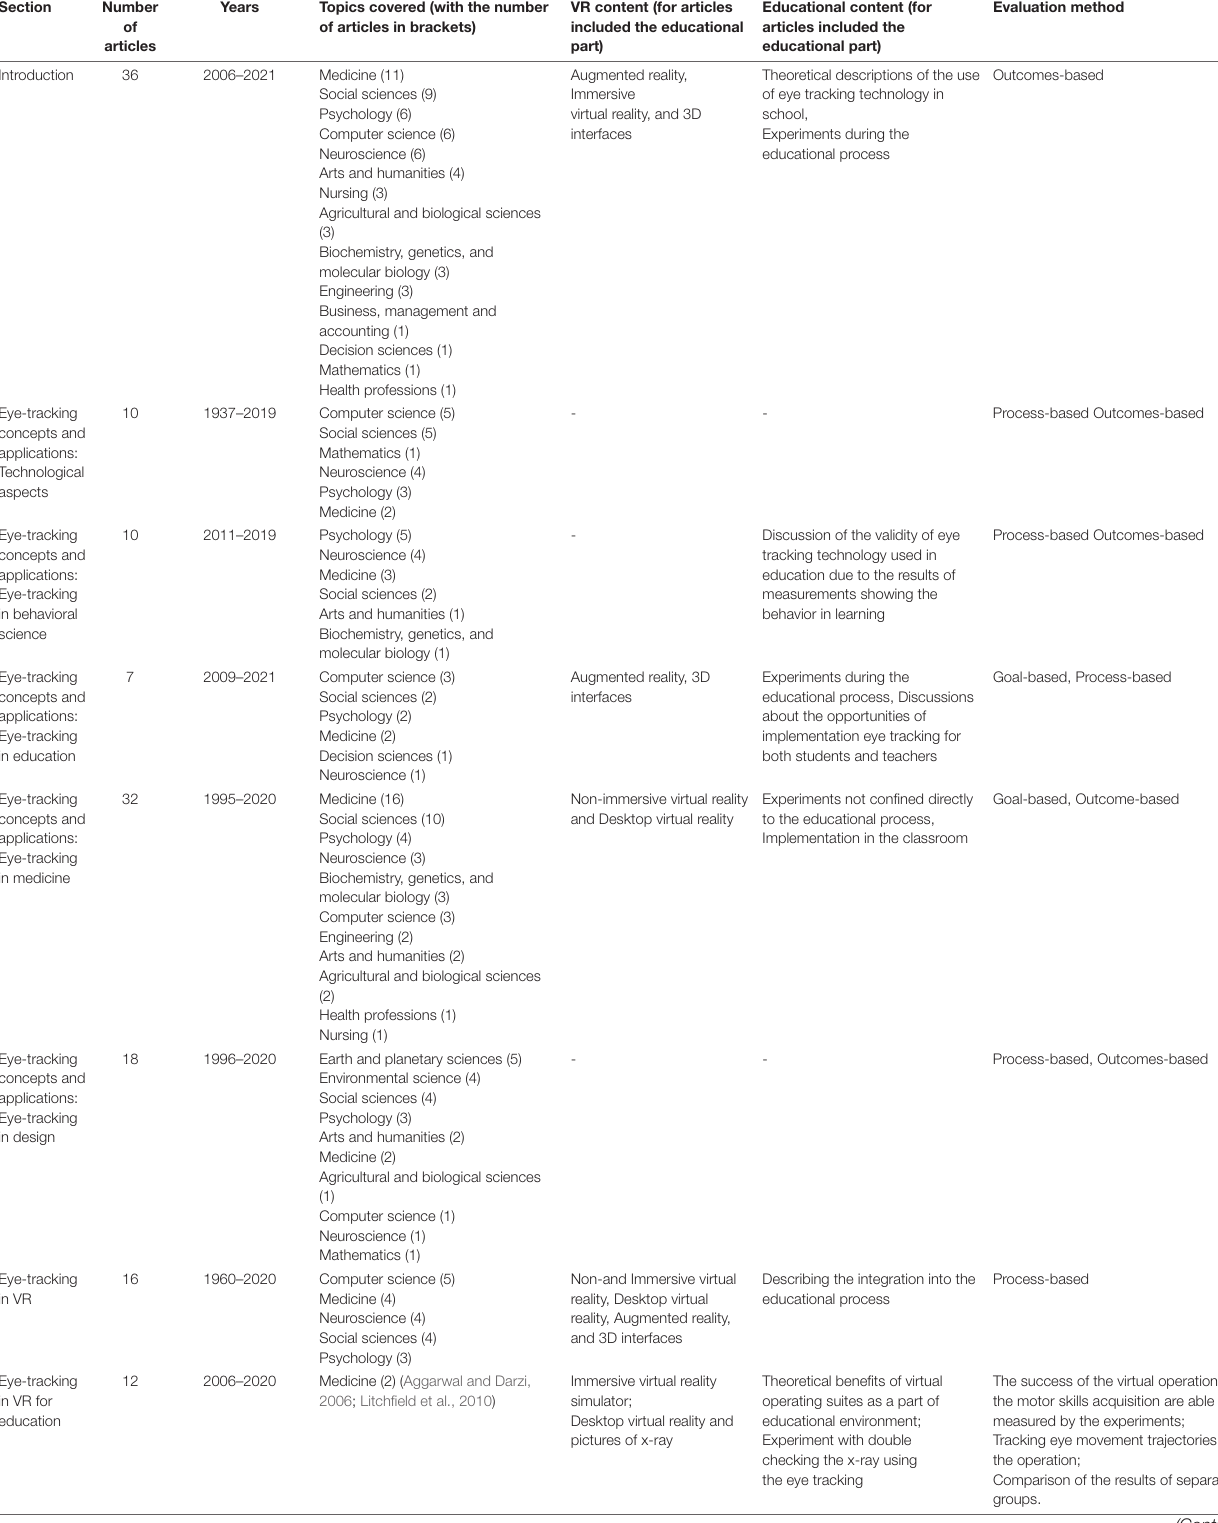
TABLE 1 | Overview of the articles used for each section of the review by topic, virtual reality (VR) content, educational content, and educational method. Section Number Years Topics covered (with the number of of articles in articles